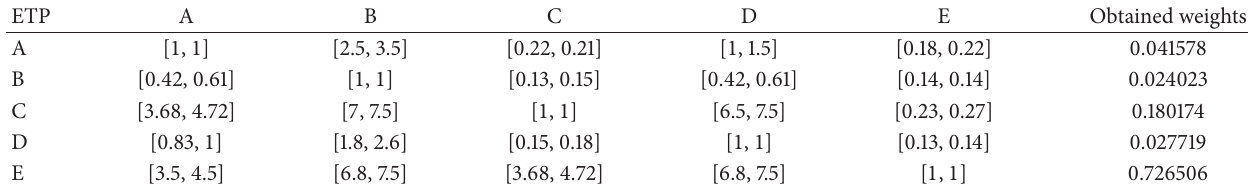
Table 14: The interval approximation choices referring to ETP subcriteria.